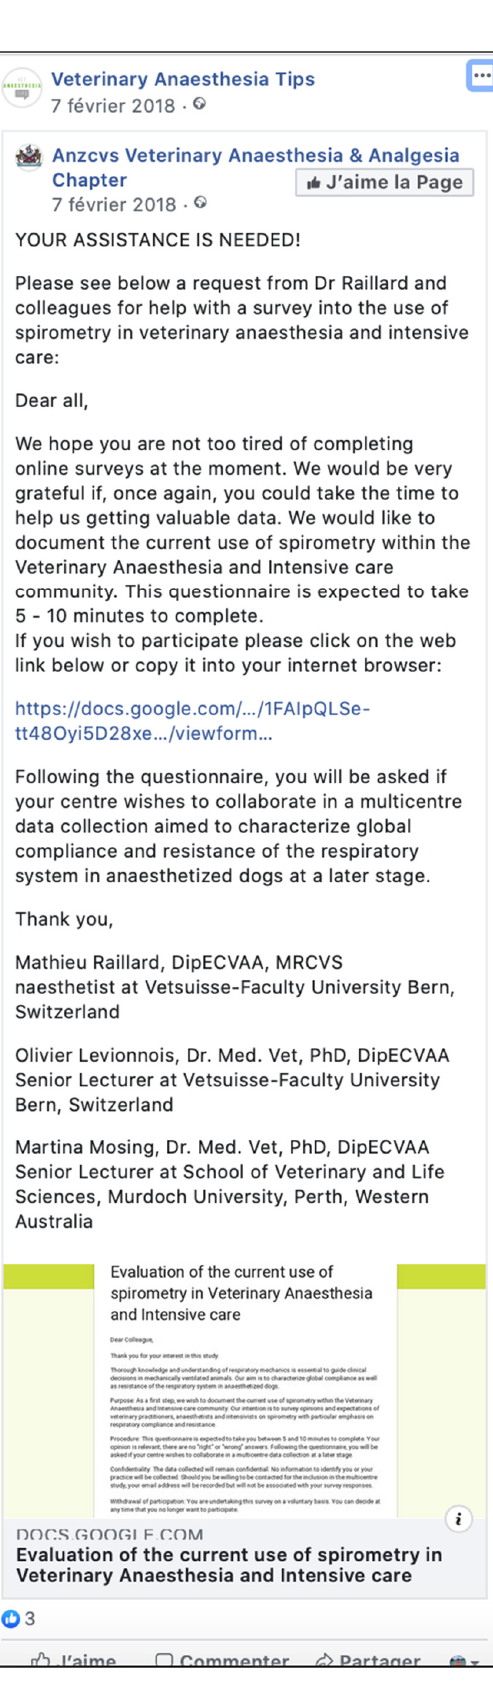
Figure A4. Example of survey announcement on the Facebook page of the Veterinary Anaesthesia Tips.